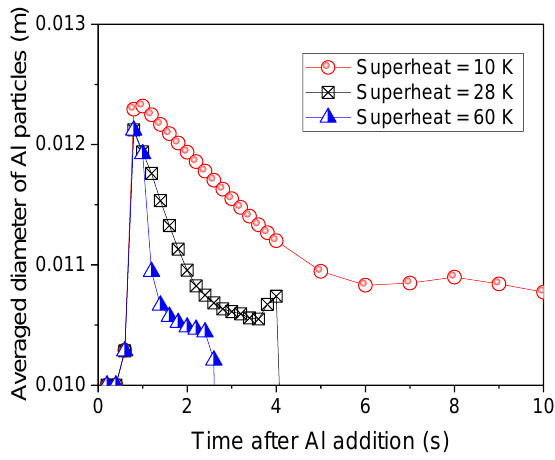
Figure 11. Variation of average aluminum particles diameter with time.